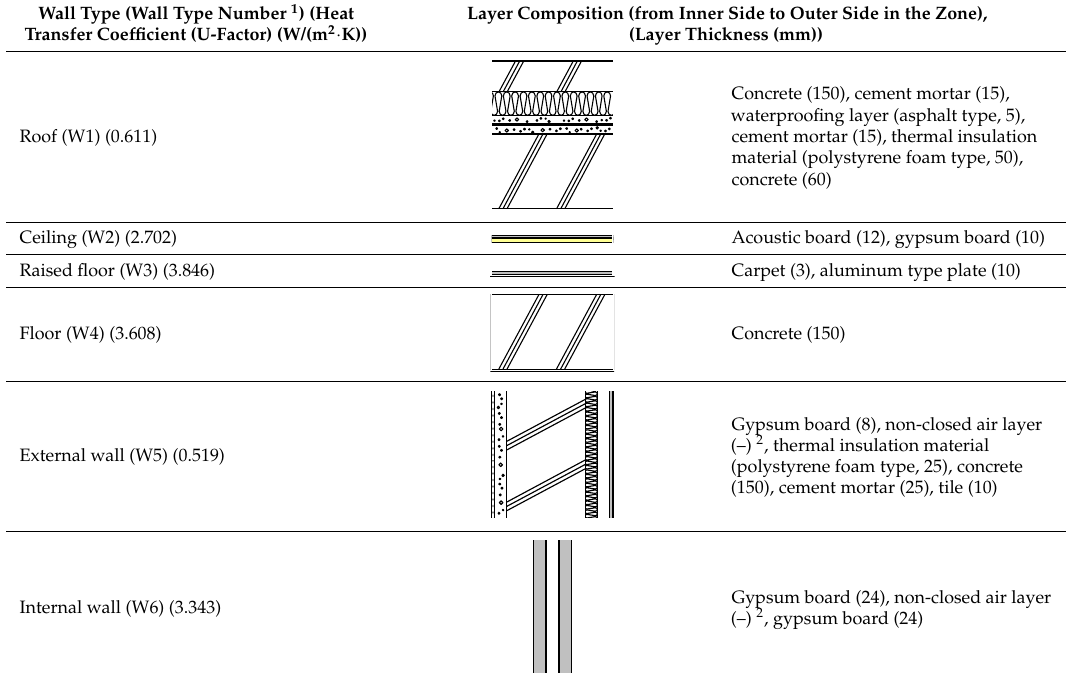
Table 1. Heat transfer coefficient and layer composition of each wall type.